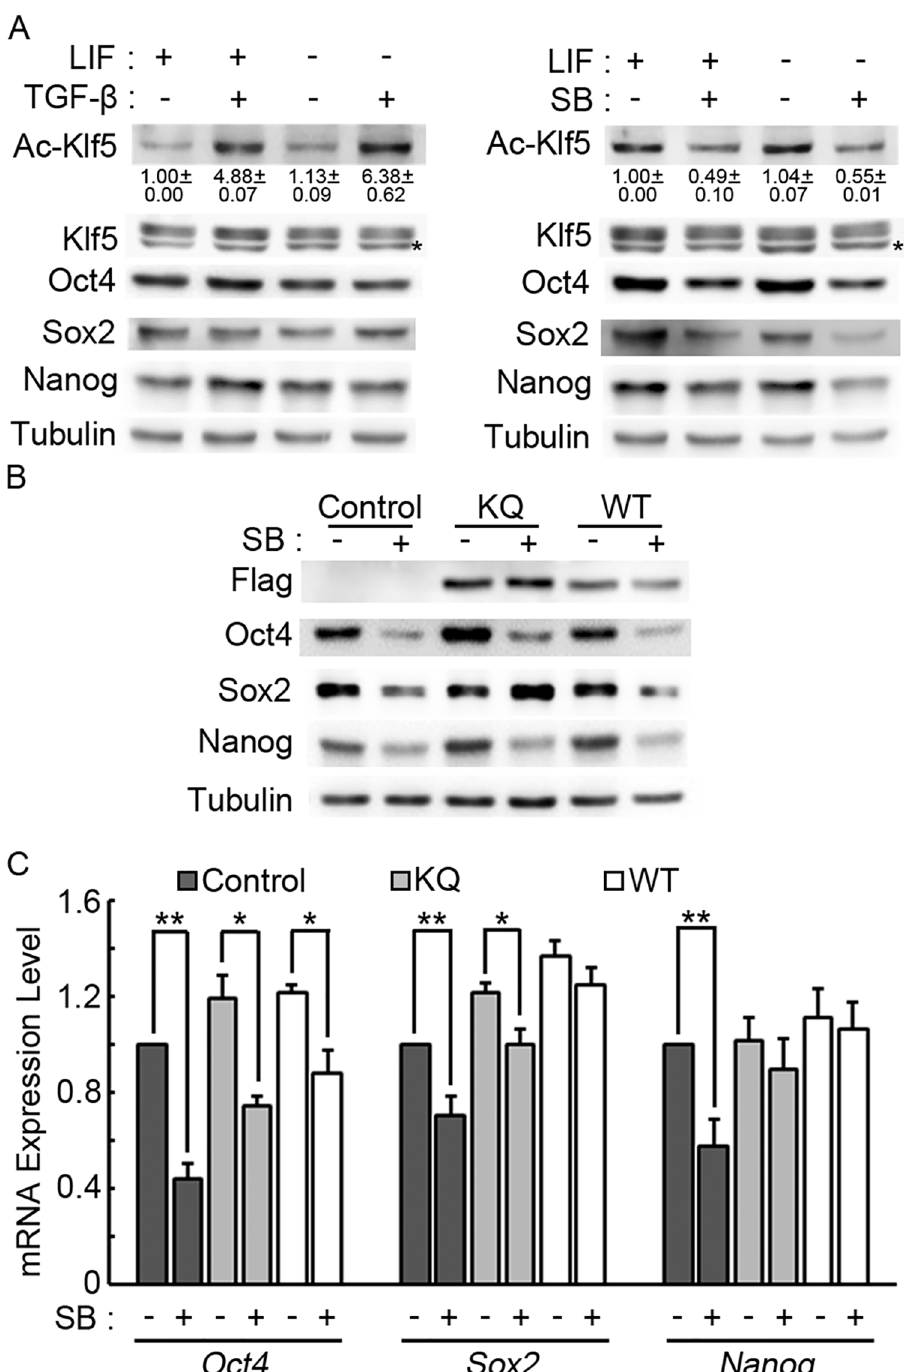
Fig 3. Klf5 acetylation, stimulated by TGF- β signaling, facilitates pluripotency maintenance in mouse ESCs. (A) TGF- β signaling promotes Klf5 acetylation. V6.5 ESCs were treated with 10 μ g/ml TGF- β or 5 μ M SB525334 (SB) for 48 hours, and then harvested for subsequent Western blot experiments. The nonspecific band in the anti-Klf5 blot is marked by an asterisk. The expression levels of Ac-Klf5 were quantified and normalized to Klf5. Averages and standard deviations of Ac-Klf5 expression from three experiments are shown. (B) Overexpression of KQ Klf5 mutant antagonizes the suppression effect of TGF- β signaling on Sox2 protein expression. Empty pCAGIPuro, Flag-tagged WT and KQ Klf5 overexpression plasmids were transfected into V6.5 ESCs. Cells were cultured in mouse ESC medium with or without 5 μ M SB525334 for